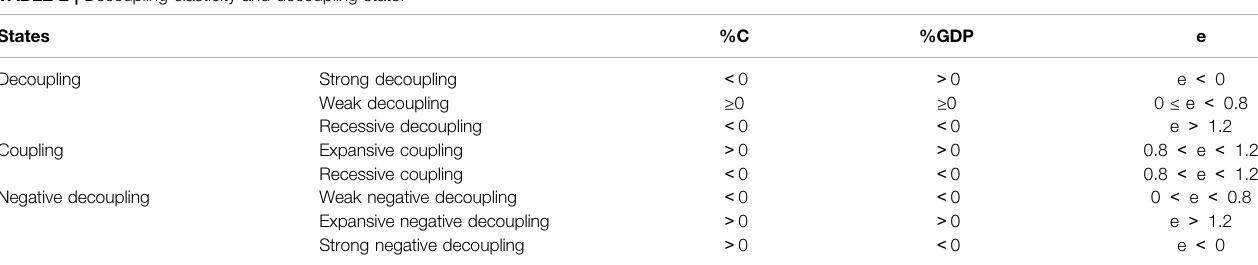
TABLE 2 | Decoupling elasticity and decoupling state.